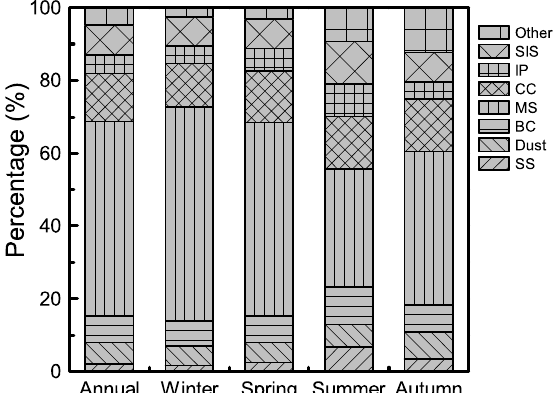
Figure 4. Seasonal variations in the source of particulate matter (SS: sea salt, BC: biomass combustion, MS: mobile source, CC: coal combustion, IP: industrial process, SIS: secondary inorganic